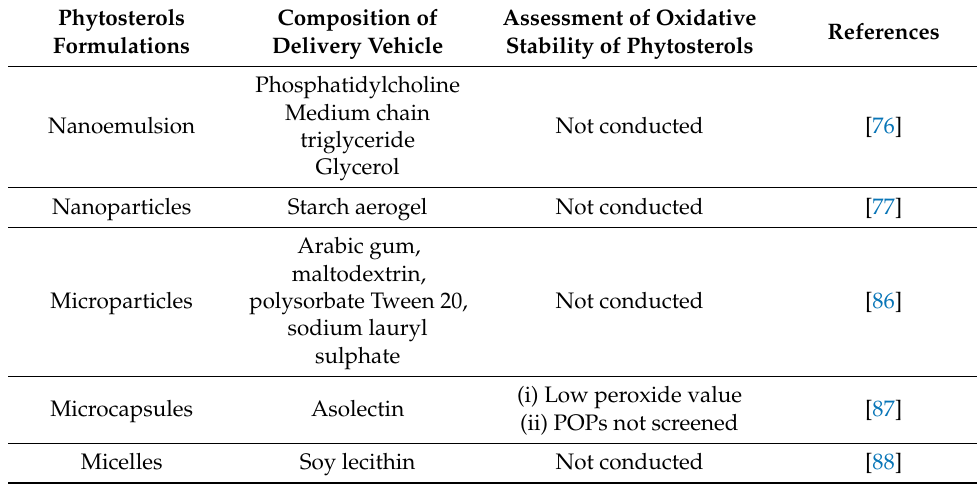
Table 2. Various formulation approaches utilized for delivering